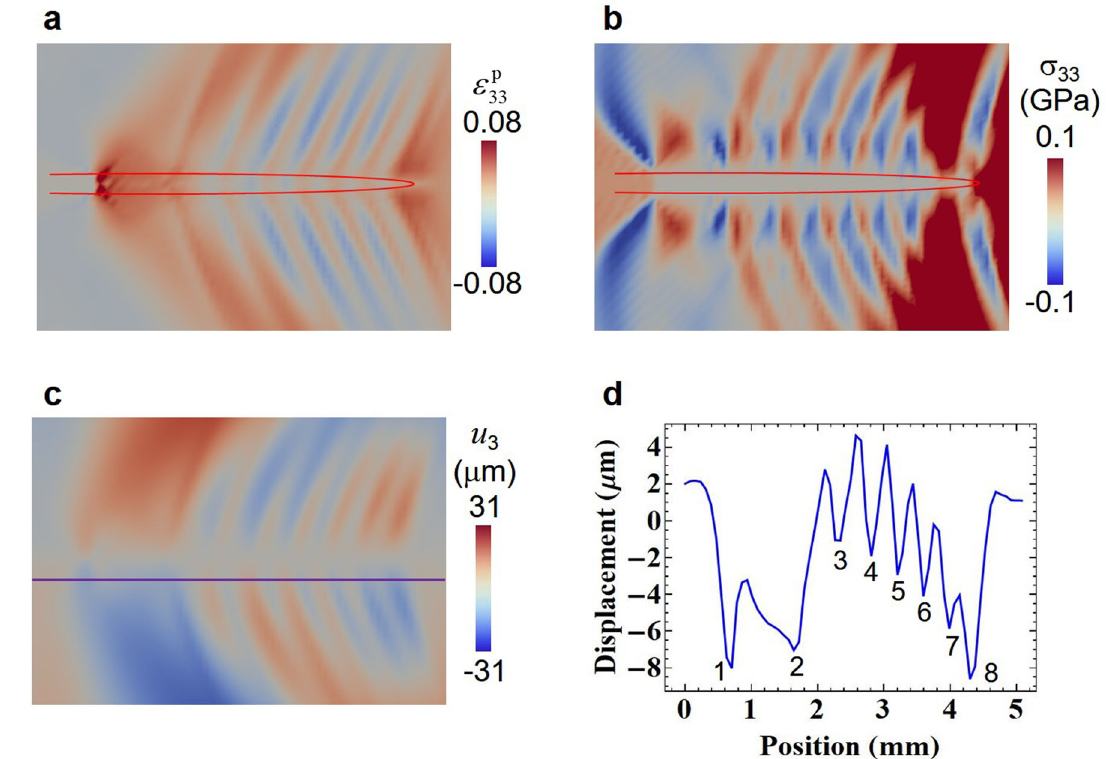
Fig. 8 Crack closure and fatigue striations after eight load cycles. a Distribution of a plastic strain component. b Distribution of a normal stress component. The red curves in ( a and b ) represent the contour of the crack. c Distribution of the displacement fi eld. d Pro fi le of the displacement along the purple line in ( c